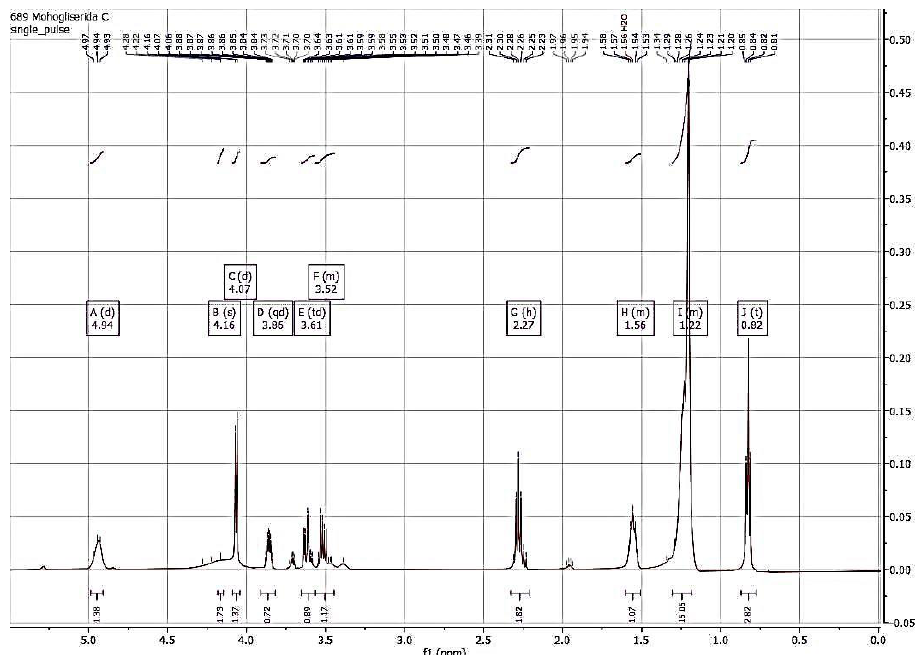
Figure 3. Spectrum 1 H NMR of monolaurin from glycerolysis reaction of PKOo-PKS blend with a ratio of 40:60 w/w for 24 h, at 40 °C, molar ratio of oil to glycerol 1:4, solvent to oil ratio of 2:1 v/w , enzyme concentration of 10% w/w , and stirring speed 600 rpm.